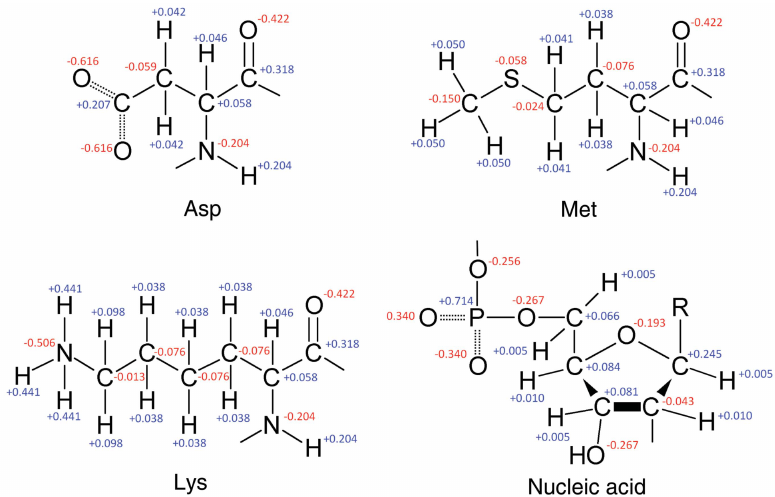
Figure 2 Theoretical charge distributions over atoms in typical amino acids and the template of a nucleic acid. Taken from the crystallographic information files (Brown & McMahon, 2002) in the PHENIX library (Adams et al. ,